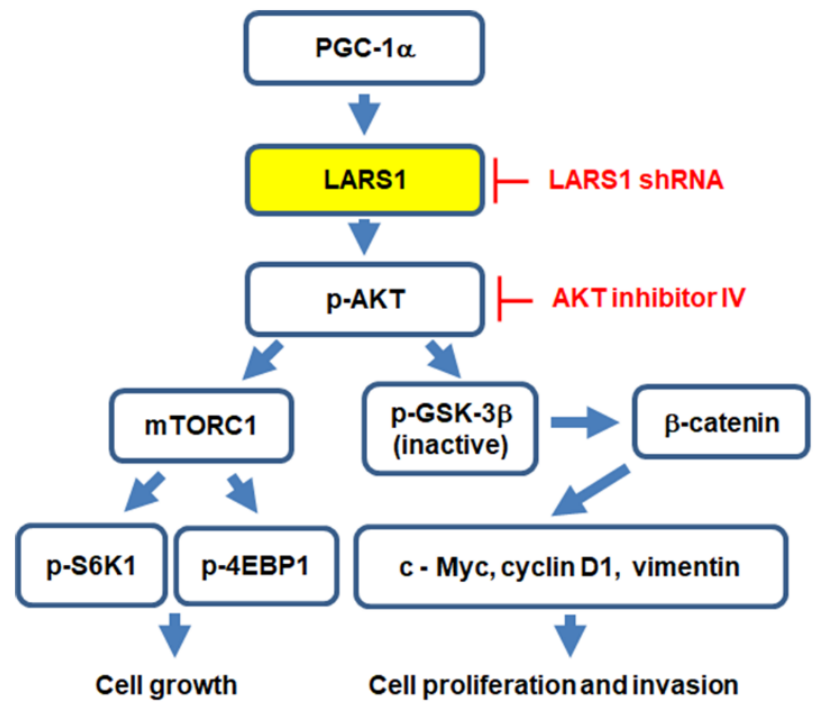
Figure 7. Potential molecular mechanism by which PGC-1 α regulates cell proliferation, migration, and invasion of human colorectal cancer cells. In summary, PGC-1 α regulates cell proliferation, migration, and invasion via regulation of LARS1/AKT/GSK-3 β / β -catenin axis.